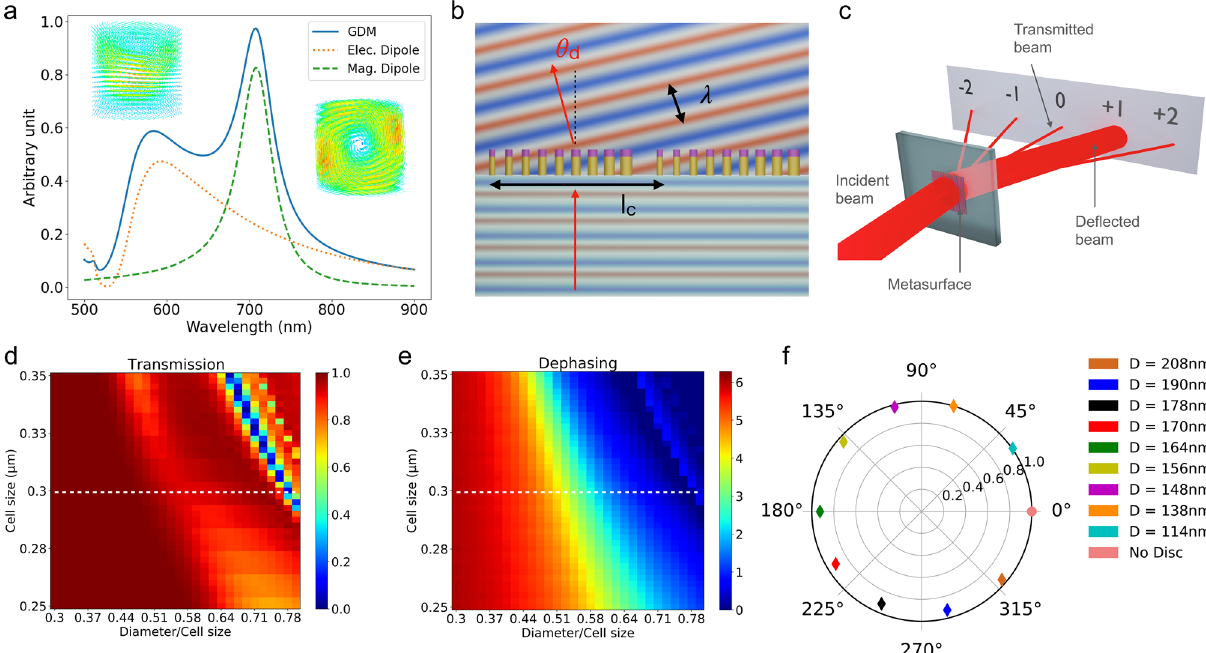
Figure 1. ( a ) Scattering cross-section of an isolated silicon nanocylinder ( H = 170 nm , D = 160 nm ). The full line shows the total scattering cross-section whereas the orange dotted (resp. green dashed) line is the contribution from the electric (resp. magnetic) dipolar resonance only. ( b ) Deflection of a plane electromagnetic wave by a metadeflector: The phaseshift induced by the dielectric nanoresonators varies along the surface yielding a global tilt of the exit wave by an angle θ d . The metadeflector is composed of several supercells composed of N d resonators. Over the supercell length l c an incident plane wave experiences a 2 π phaseshift. ( c ) A plane wave incident on a metadeflector is split into several output beams. The deflected beam carries nearly all the transmitted power. Transmission efficiency ( d ) and dephasing ( e ) of a (cid:31) c = 750 nm plane wave normally incident on an infinite square array of silicon nanocylinders with constant height H = 370 nm . The white dashed line corresponds to the lattice spacing chosen in the following. ( f ) Polar plot showing the transmission and dephasing of a (cid:31) c = 750 nm plane wave normally incident on a periodic array of identical nanocylinders with selected diameters. The height and spacing are the same for all nanocylinders ( H = 370 nm and a = 300 nm respectively). The transmission and dephasing are respectively given by the distance to the center and